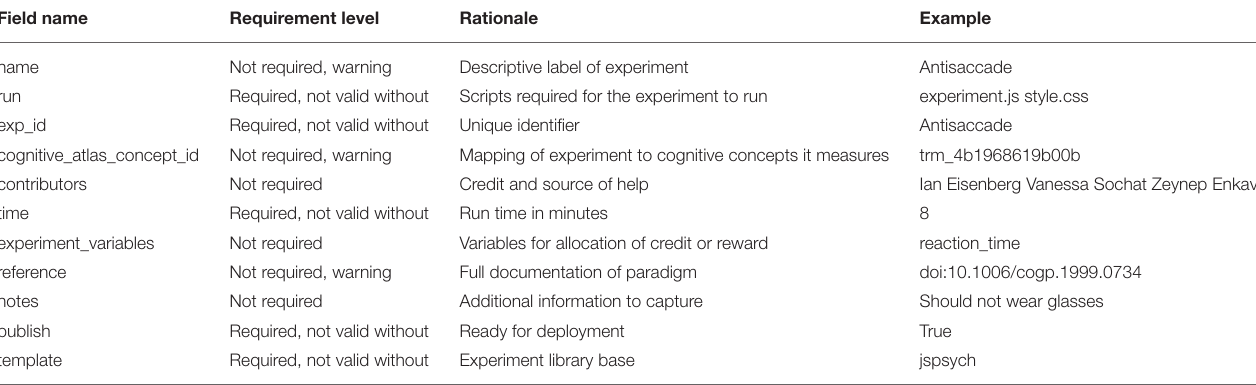
TABLE 1 | The fields required in the standard config.jsonž for an Experiment Factory